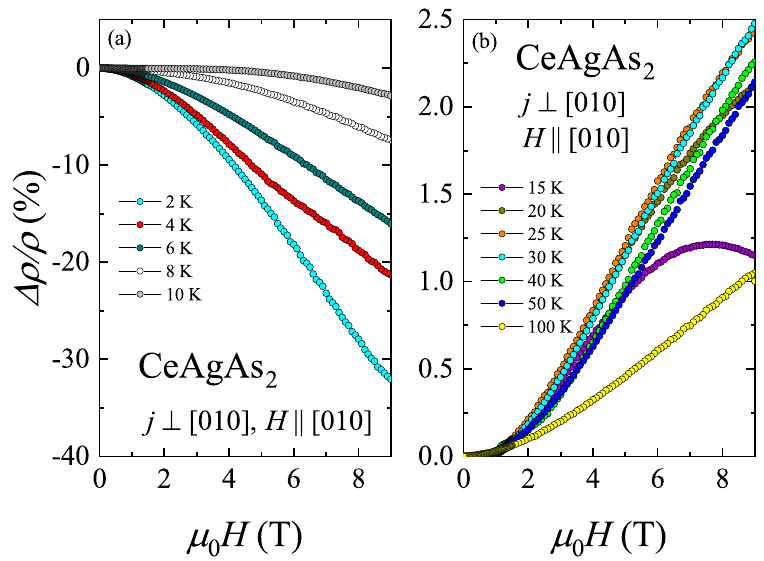
Figure 12. ( a ) The transverse magnetoresistance of CeAgAs 2 measured as a function of magnetic field in the temperature intervals 2–10 K, and ( b ) 15–100 K (right-hand-side